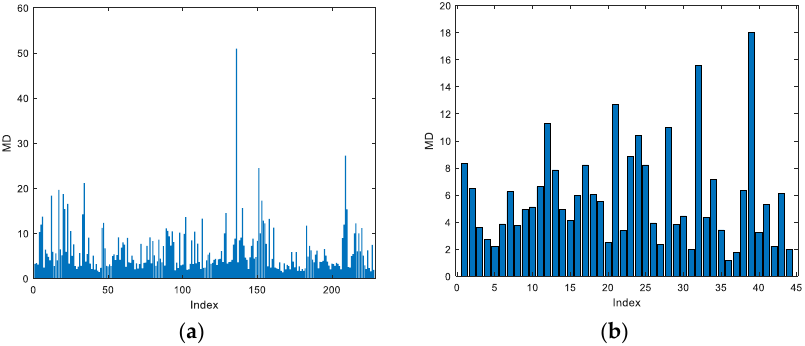
Figure 3. ( a ) Mahalanobis Distance (MD) for positive samples; ( b ) MD for negative samples.